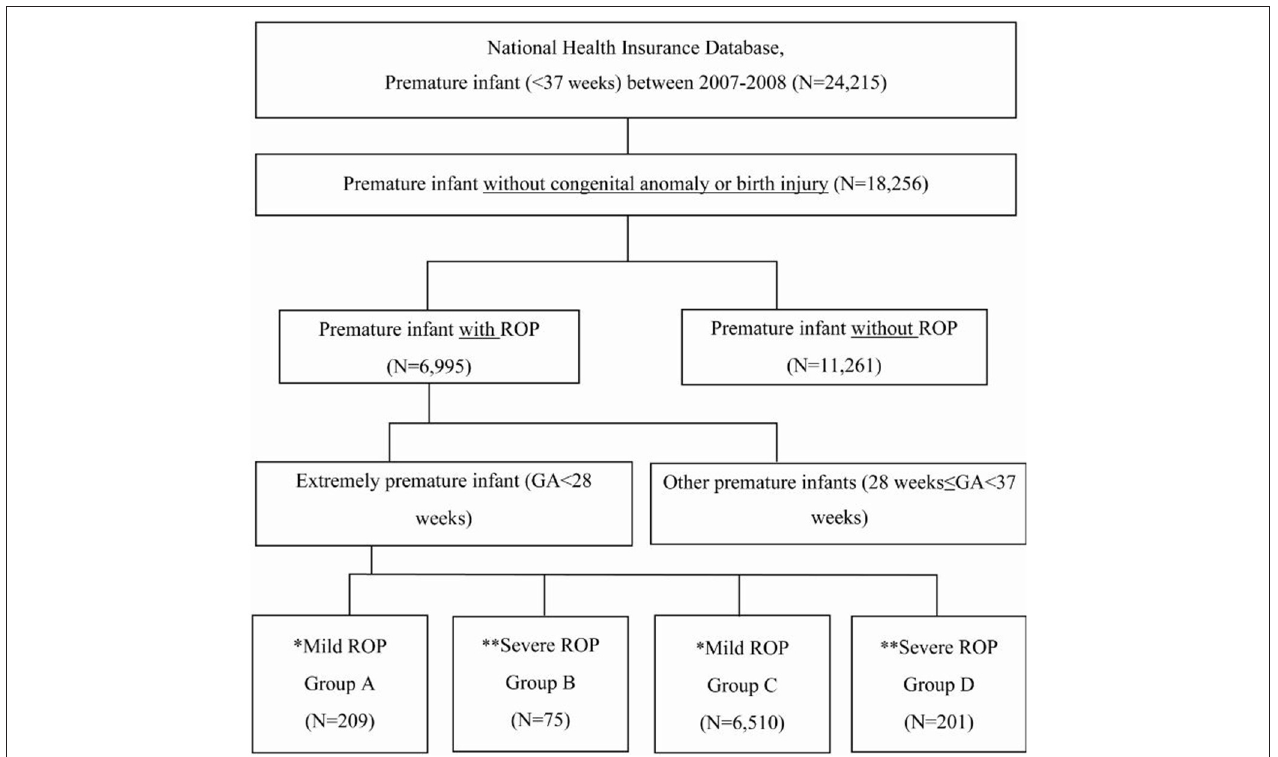
FIGURE 1 | Enrollment and grouping of study patients according to gestational age and retinopathy of prematurity severity. GA, gestational age. *Mild ROP: spontaneously healed without special treatment. **Severe ROP: underwent treatment for ROP.